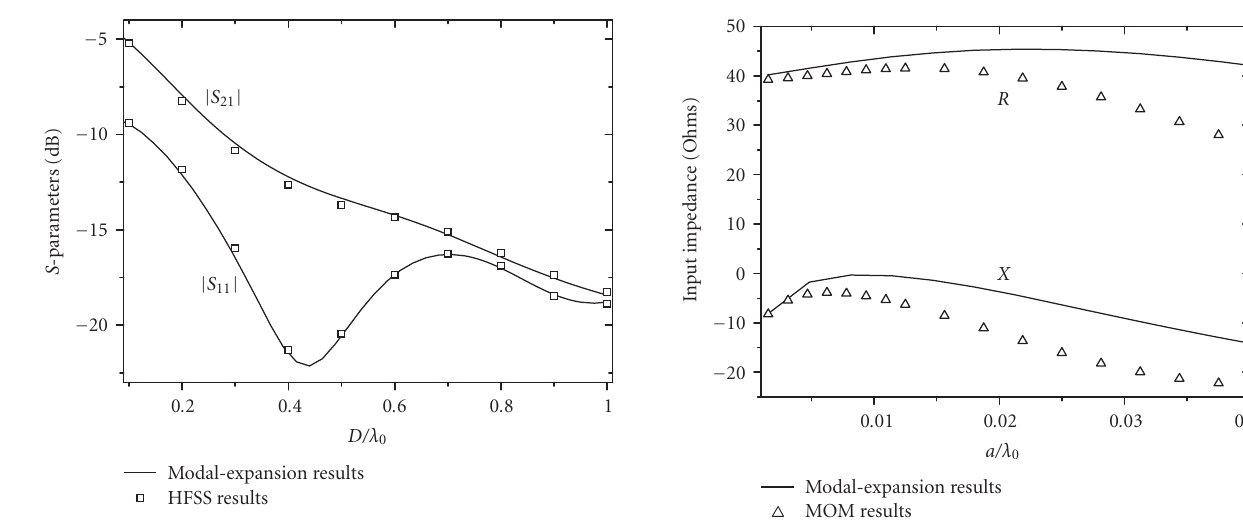
Figure 7: Variation of the input impedance of a two-monopole an- tenna with respect to their radii ( f = 0.9375 GHz, D = 160 mm ) .